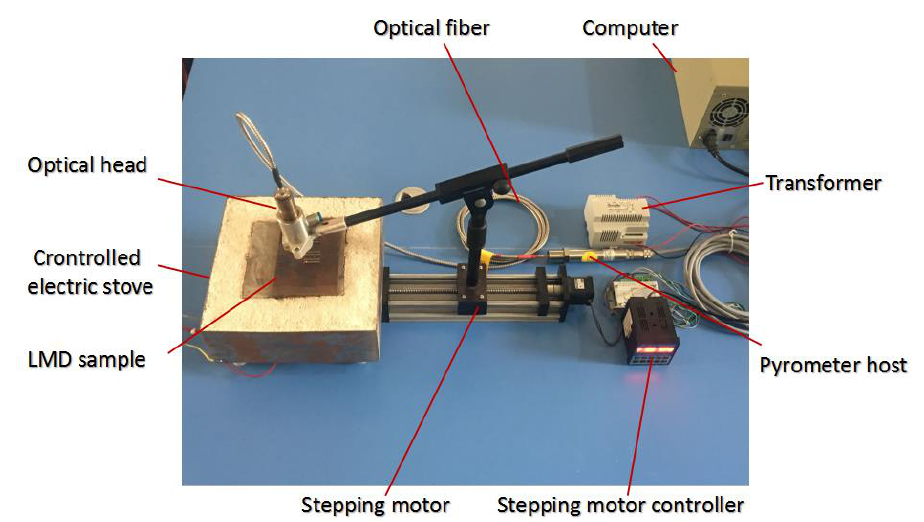
Figure 5. The experimental configuration used to detect the cracks in LMD samples.